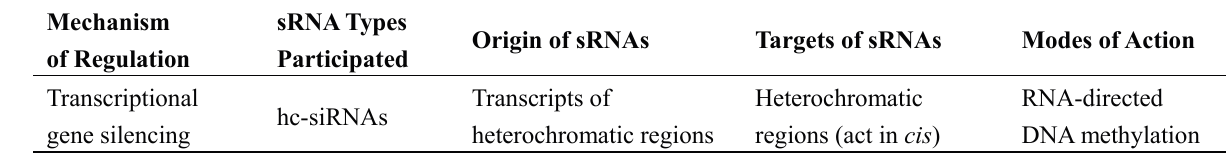
Table 1. Summary of sRNA-mediated gene regulation